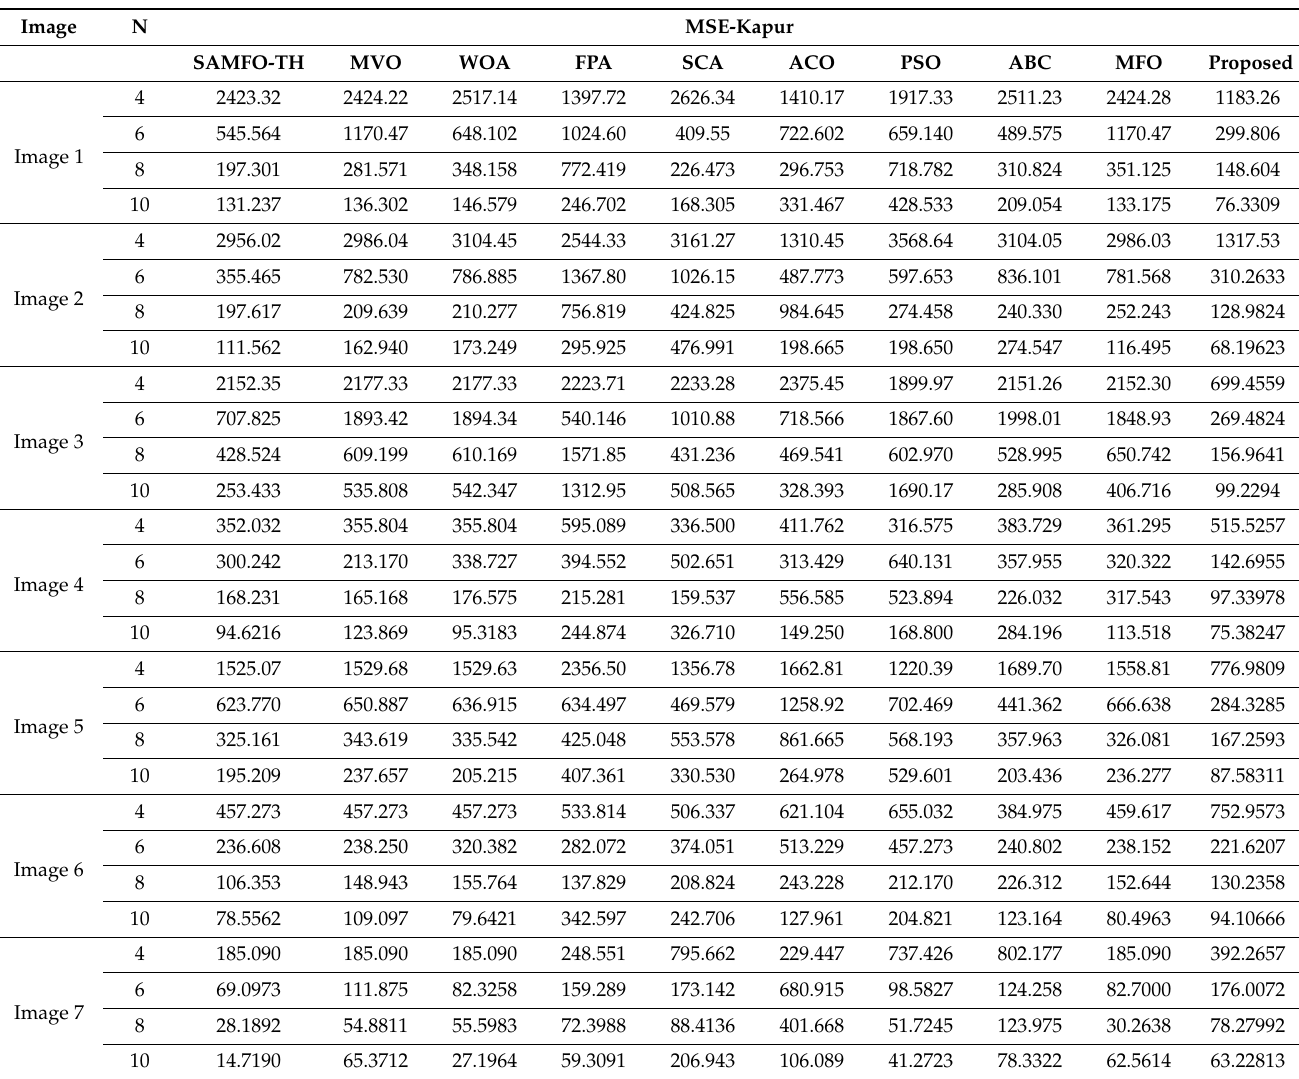
Table 3. Comparison of MSE computed by SAMFO-TH, MVO, WOA, FPA, SCA, ACO, PSO, ABC, and MFO with the proposed model using Kapur’s method with N = 4, 6, 8, and